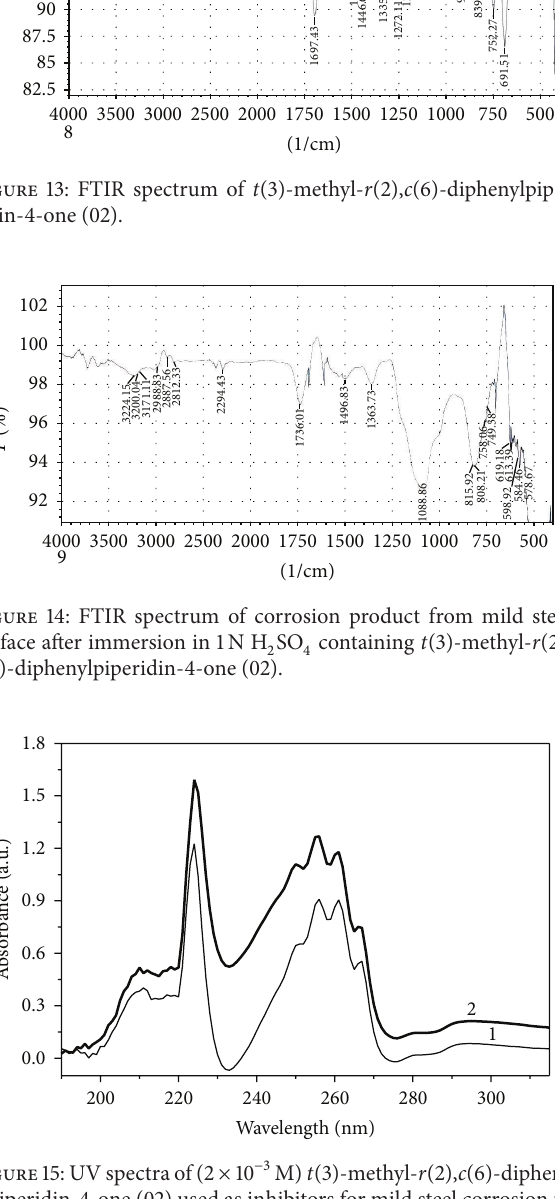
lower frequency region (3224 to 3171 cm −1 ) and is broadened in the IR spectrum of the adsorbed